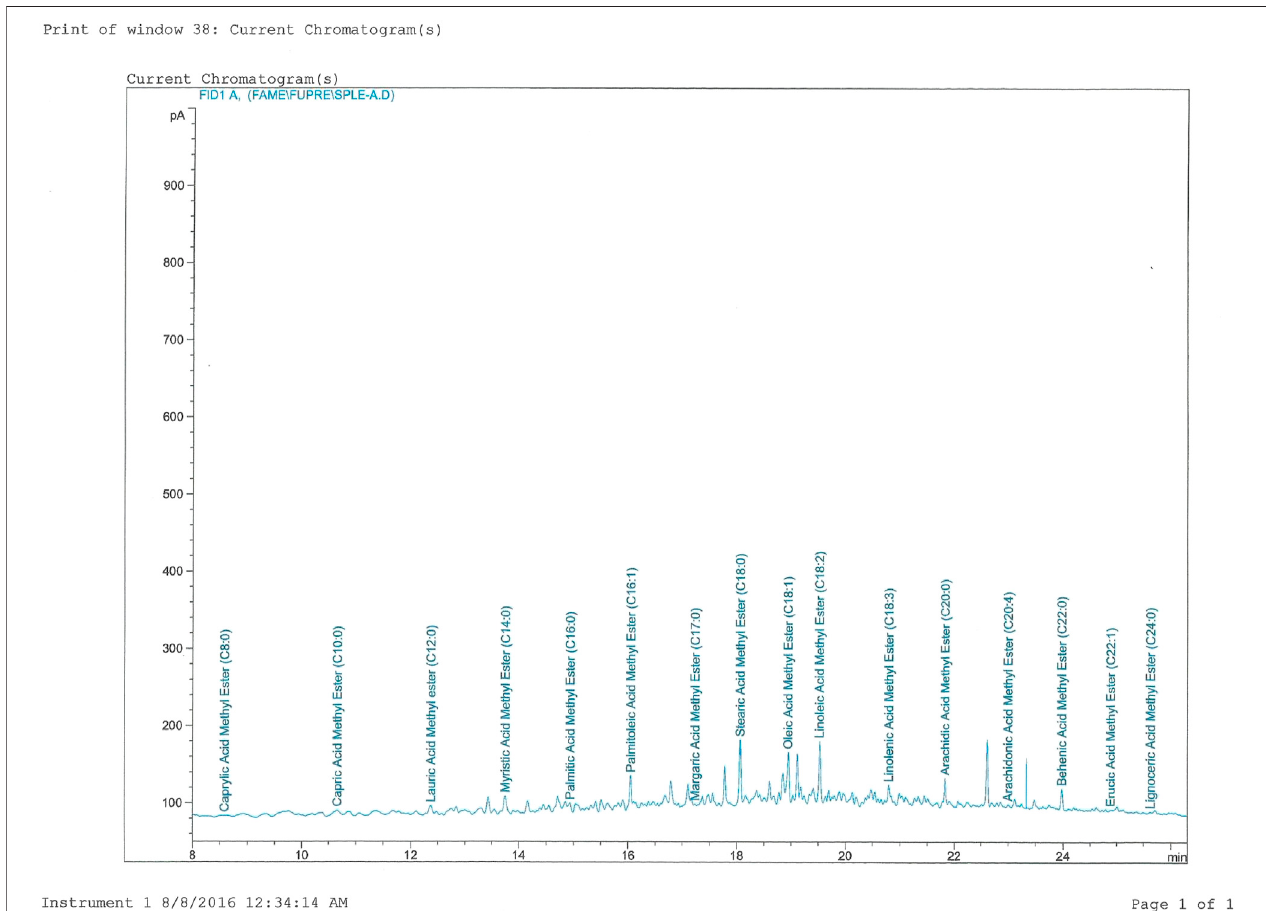
FIGURE 4 | Tobacco seed oil ’ s GC